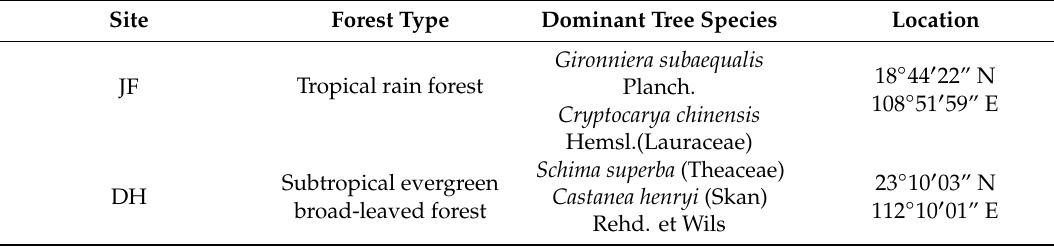
Figure 1. Locations of the sampling sites in six forest types of eastern China. TRF, tropical rain forest; SEB, subtropical evergreen broad-leaved forest; WDB, warm-temperate deciduous broad-leaved forest; TDB, temperate needle-leaf and deciduous broad-leaved mixed forest; CDN, cold-temperate deciduous needle-leaf forest; TS, temperate steppe; TD, temperate desert; PV, Qinghai–Tibet Plateau alpine vegetation; JF, Jianfeng Mountain; DH, Dinghu Mountain; BT, Baotian Mountain (forest type: subtropical evergreen-deciduous broad-leaved mixed forest (SED)); DL, Dongling Mountain; CB, Changbai Mountain; MH, Mohe. Table 1. Site information for the six forest types in eastern